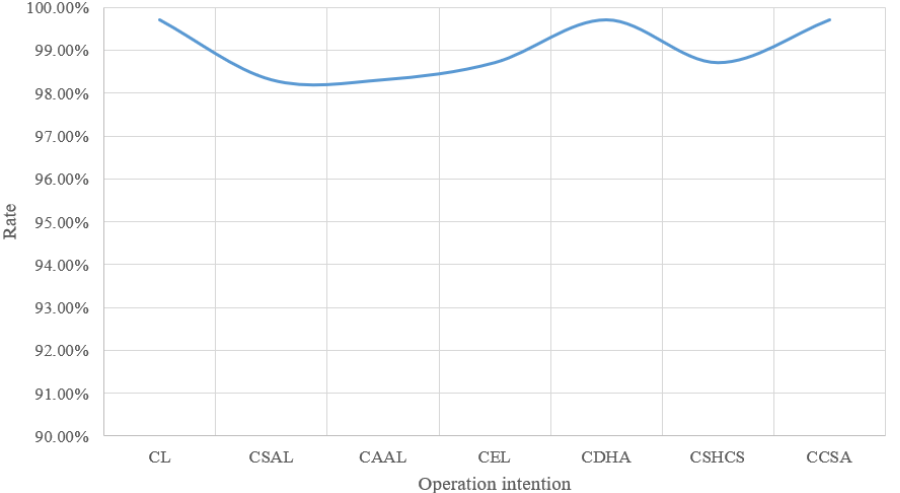
Figure 16. Success rate.